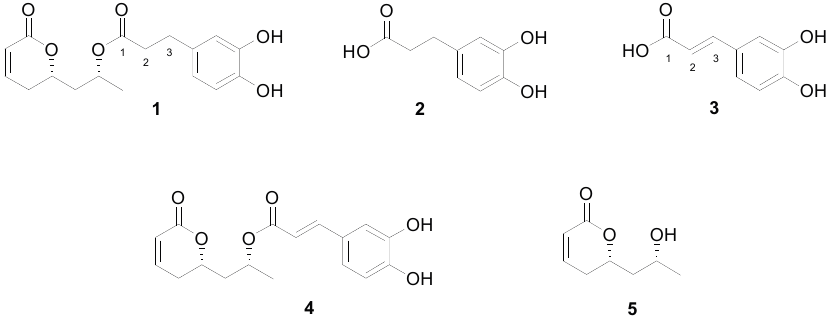
Figure 1. Chemical structures of compounds 1 – 5